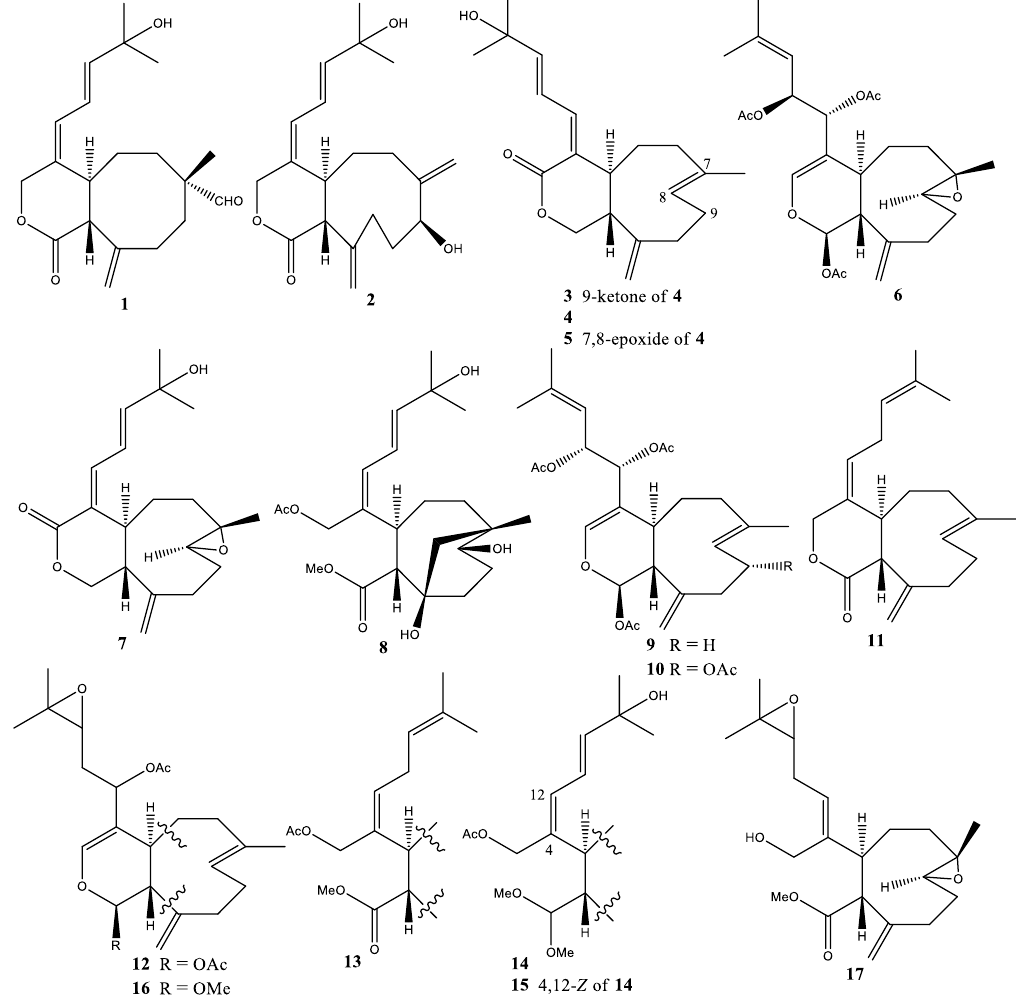
Figure 2. Structures of compounds 1 – 17 .